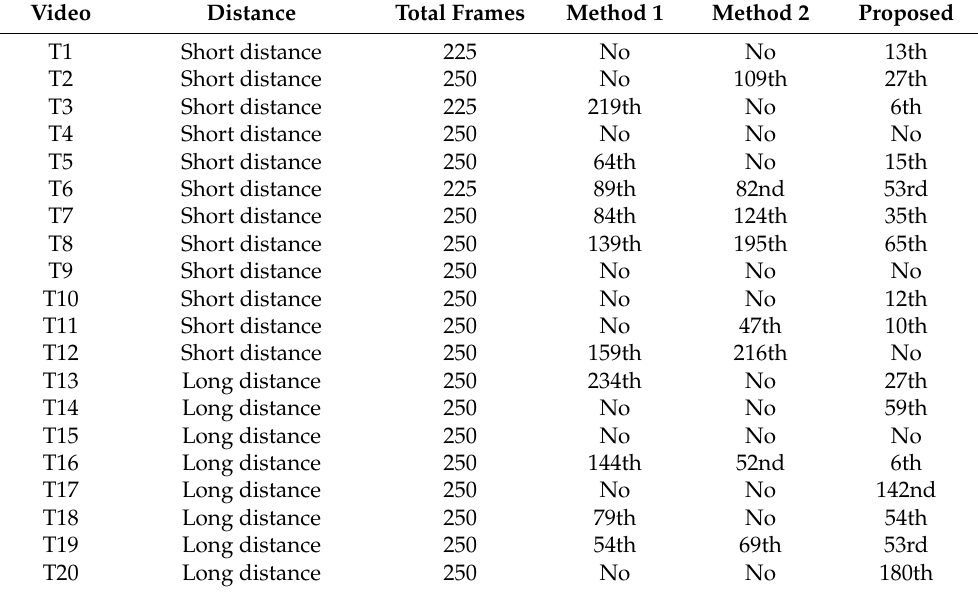
Table 2. Appearance times of the smoke